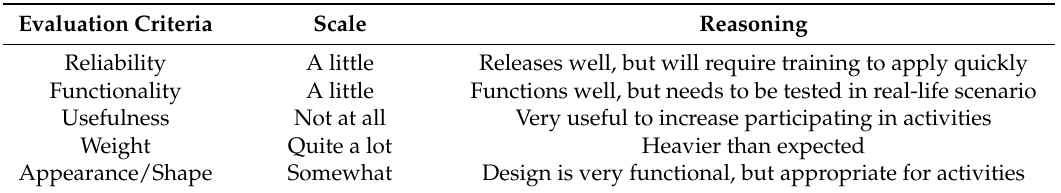
Table 3. Qualitative evaluation—subject-reported